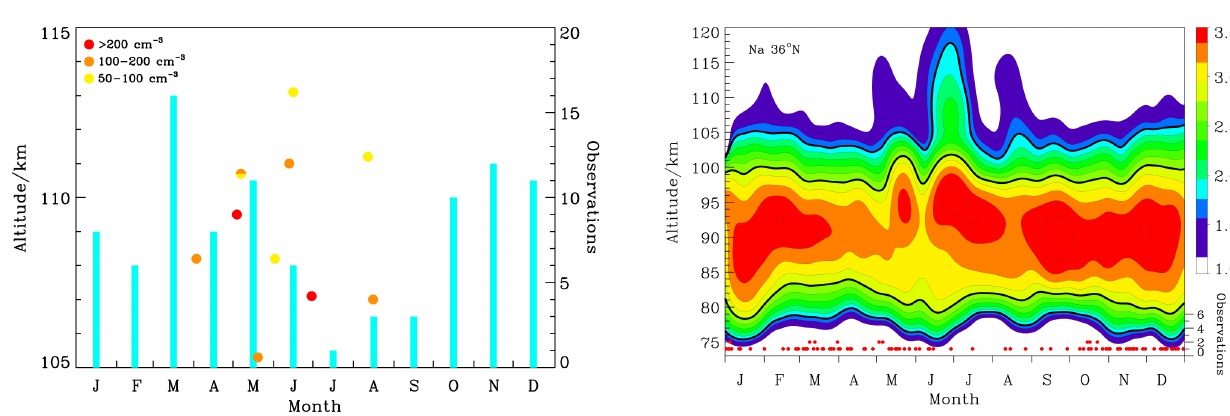
Figure 9. Seasonal distribution of peak altitudes for the high- altitude Na s layers over Qingdao (36 ◦ N). The peak densities are denoted by the color of solid circles. Cyan bars represent the night number of the lidar measurements in each month. Note that high- altitude Na s layers all occurred from April to August.